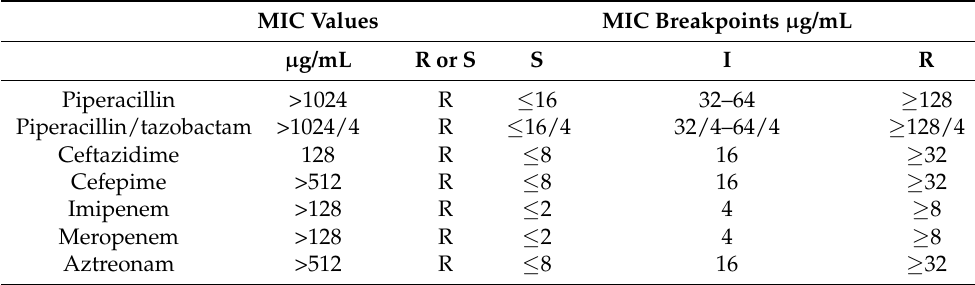
Table 1. Minimum inhibitory concentration (MIC) values of P. aeruginosa R31 determined by the microdilution